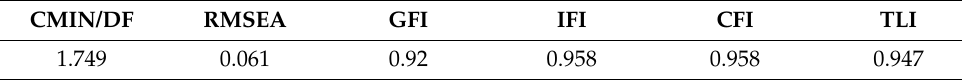
Table 5. Results of model fit test.